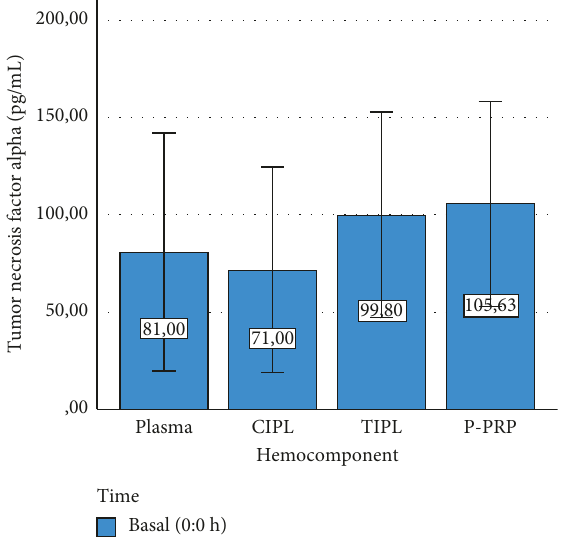
Figure 4: Mean ± sd basal tumor necrosis factor alpha concentration in hemocomponents.